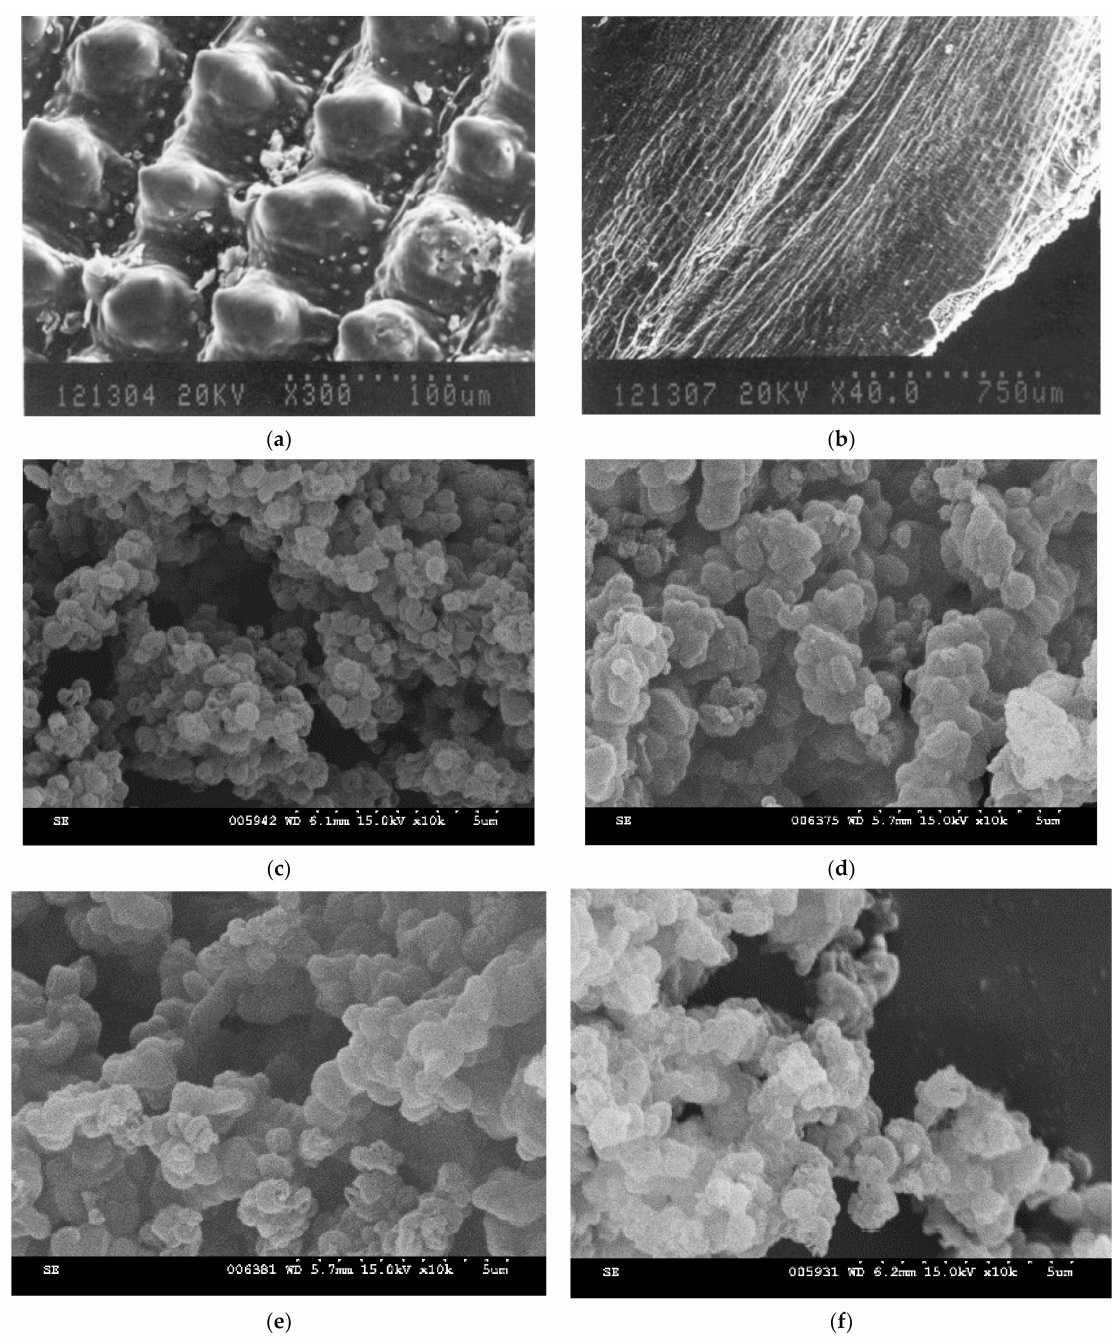
Figure 5. FE-SEM images: ( a ) outer epidermis of RH, ( b ) inner surface of RH, ( c ) RH-SBA-15, and different amounts of GO suspension ( d ) 1.5 g, ( e ) 3.0 g and ( f ) 6.0